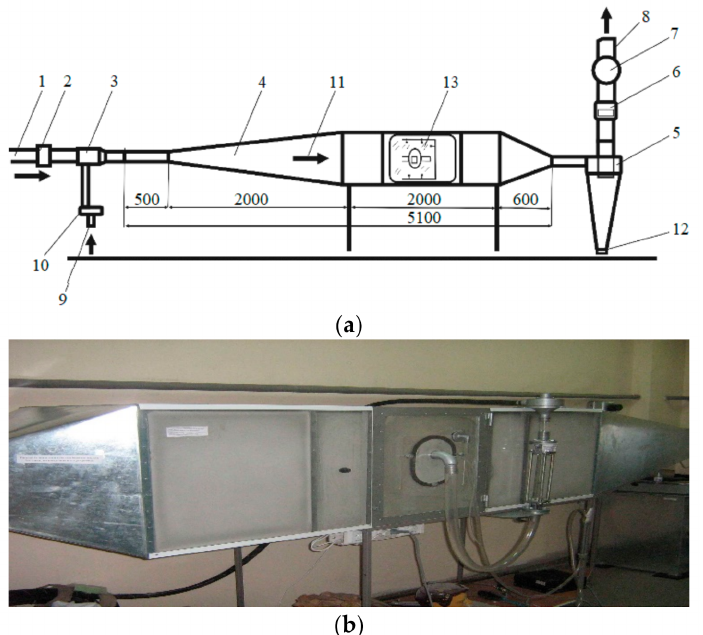
Figure 4. Test stand: ( a ) schematic view; ( b ) general view; 1, 9: compressed air supply; 2: pre- filter for compressed air treatment; 3: ejector; 4: diffuser; 5: cyclone; 6: flowmeter; 7: exhaust fan; 8: